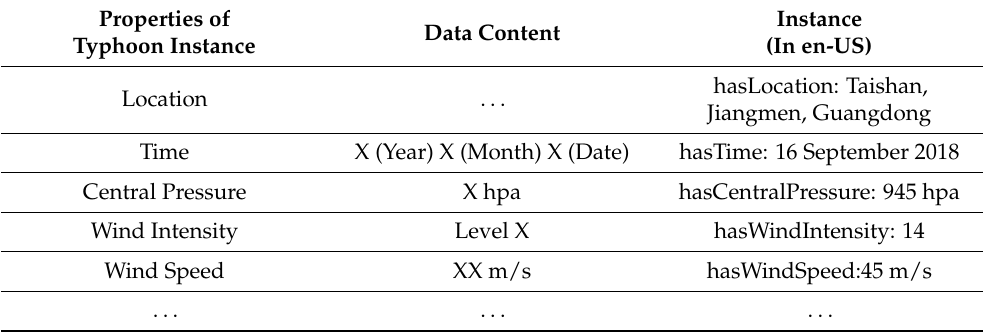
Table 2. Part of Typhoon Instance description.